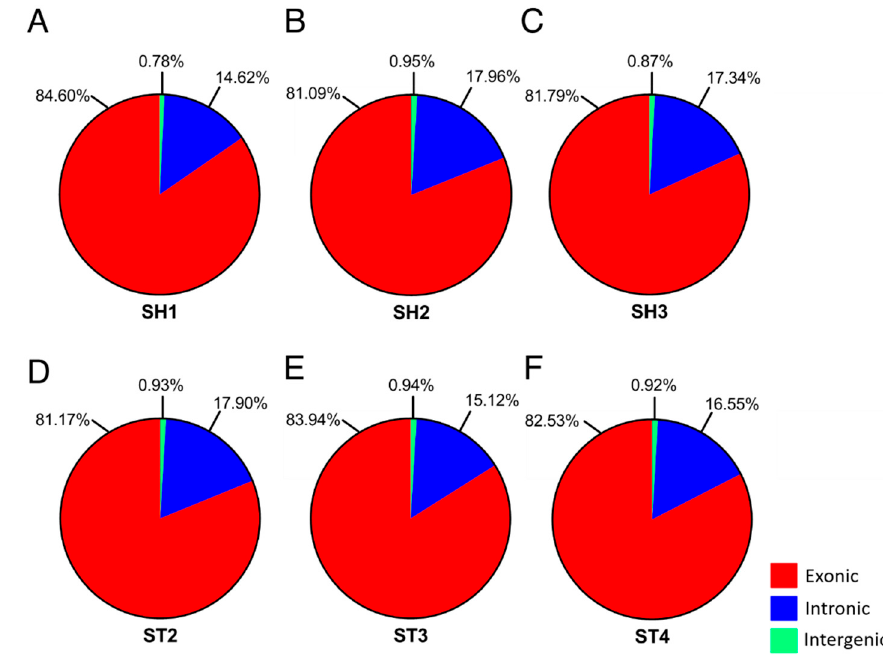
Figure 3. Statistics of mapped regions for SH1 ( A ), SH2 ( B ), SH3 ( C ), ST2 ( D ), ST3 ( E ), and ST4 ( F ) demonstrate that exonic regions account for the largest percentage of mapped reads in all samples, followed by intronic and intergenic regions.